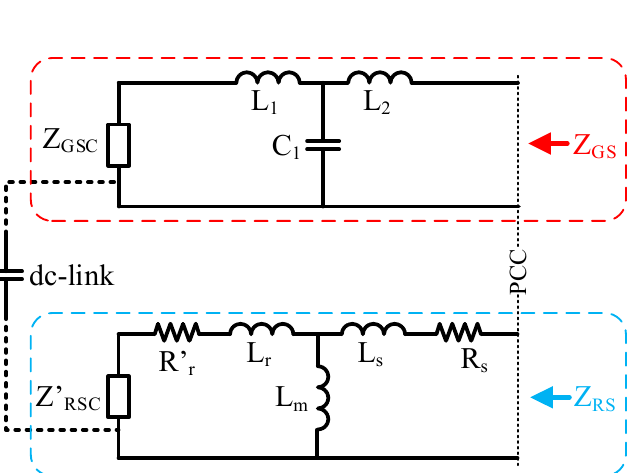
Figure 2. Electrical connection of the grid side and rotor side of the DFIG under normal operation (based on [15]).